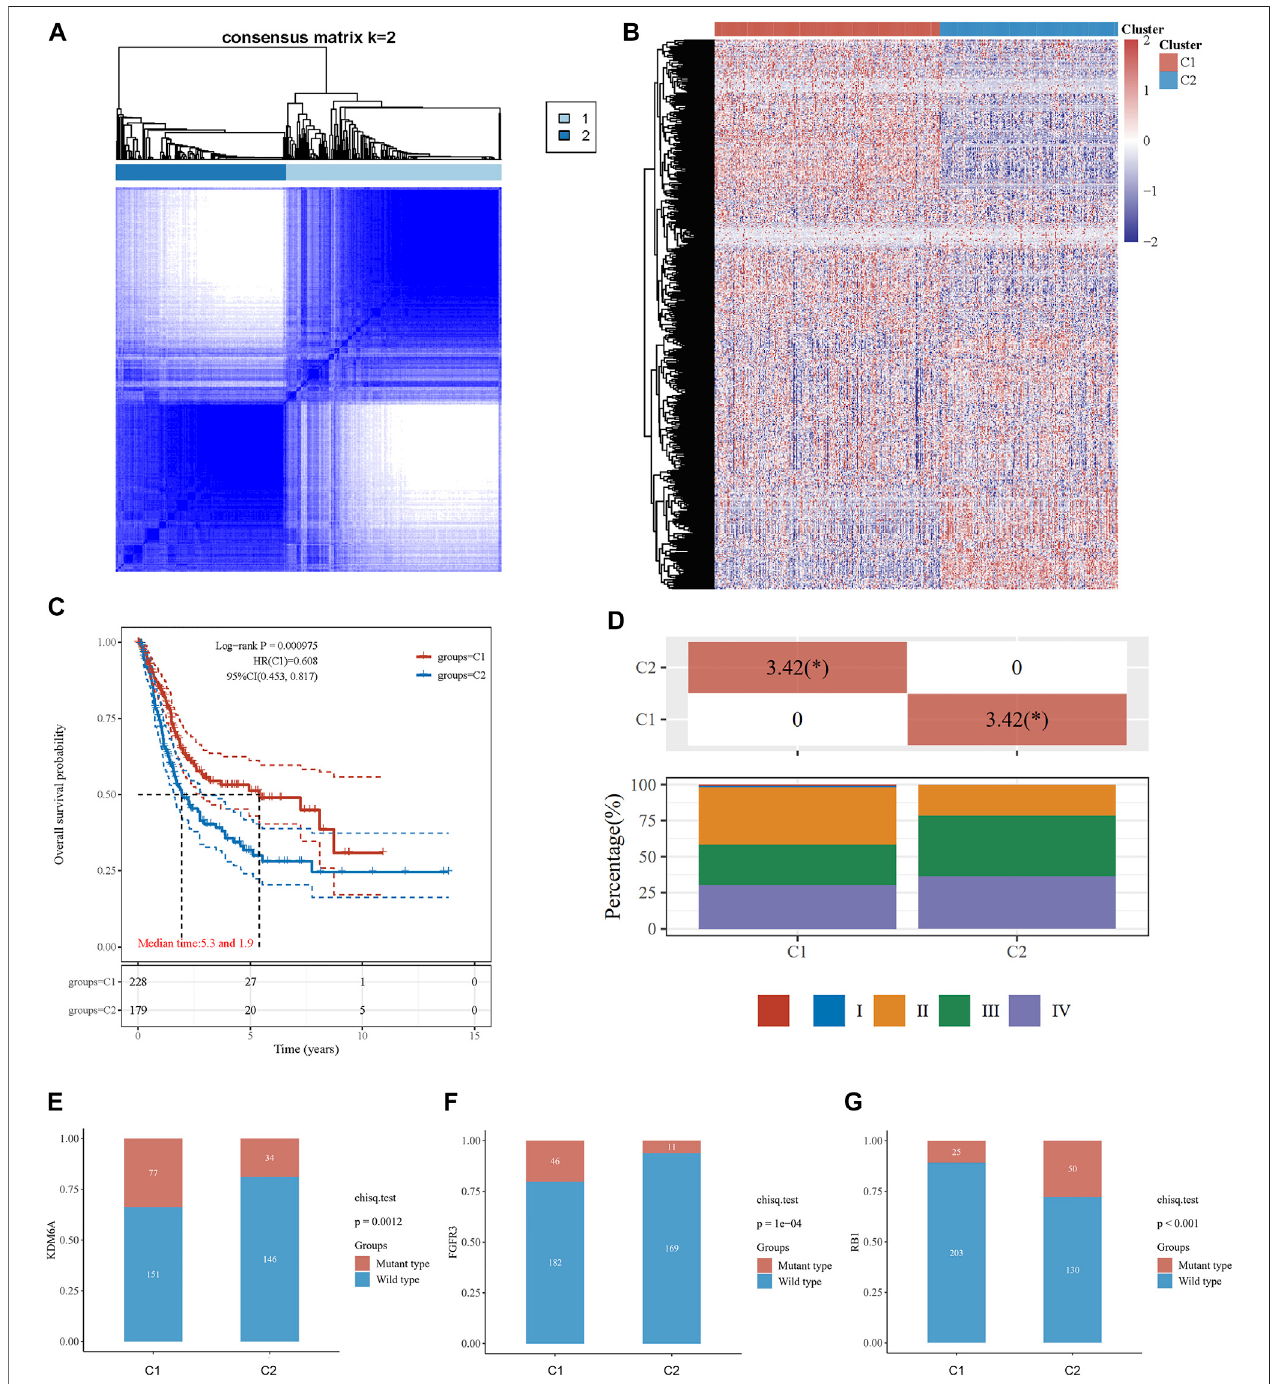
FIGURE 1 | Consensus clustering analysis to identify the genomic subtype of BLCA based on an energy metabolism-related gene set. (A) Consensus clustering matrix of 408 samples from the TCGA dataset for k = 2. (B) Heatmap of energy metabolism-related gene expression in different clusters. Red represents high gene expression,andbluerepresentslowexpression. (C) TheKaplan – MeiercurveofoverallsurvivalofBLCApatientsintwoclusters. (D) TumorstagedistributionofBLCApatients in two clusters with different metabolic statuses. The frequency of KDM6A (E) , FGFR3 (F) , and RB1 (G) mutations in two clusters with different metabolic statuses.